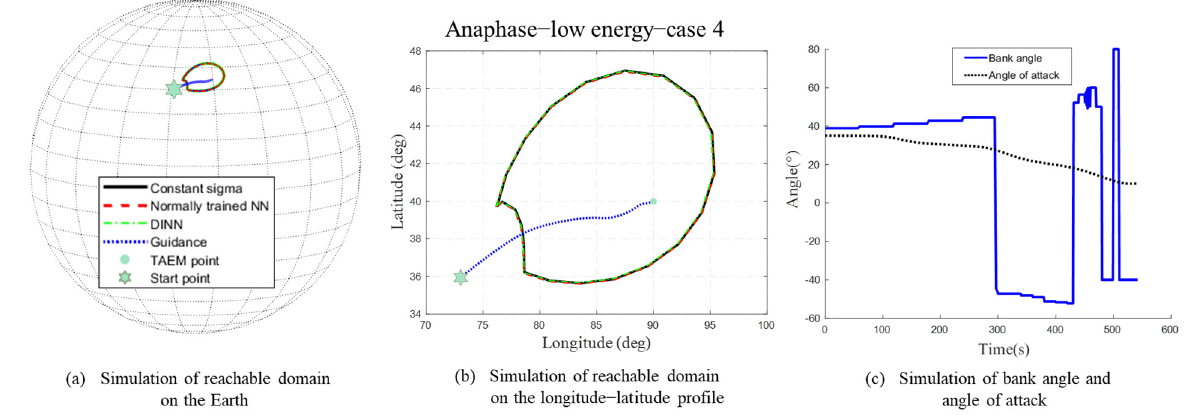
Figure 13. Simulation of low energy Case 4. Table 9. Comparison of each method.